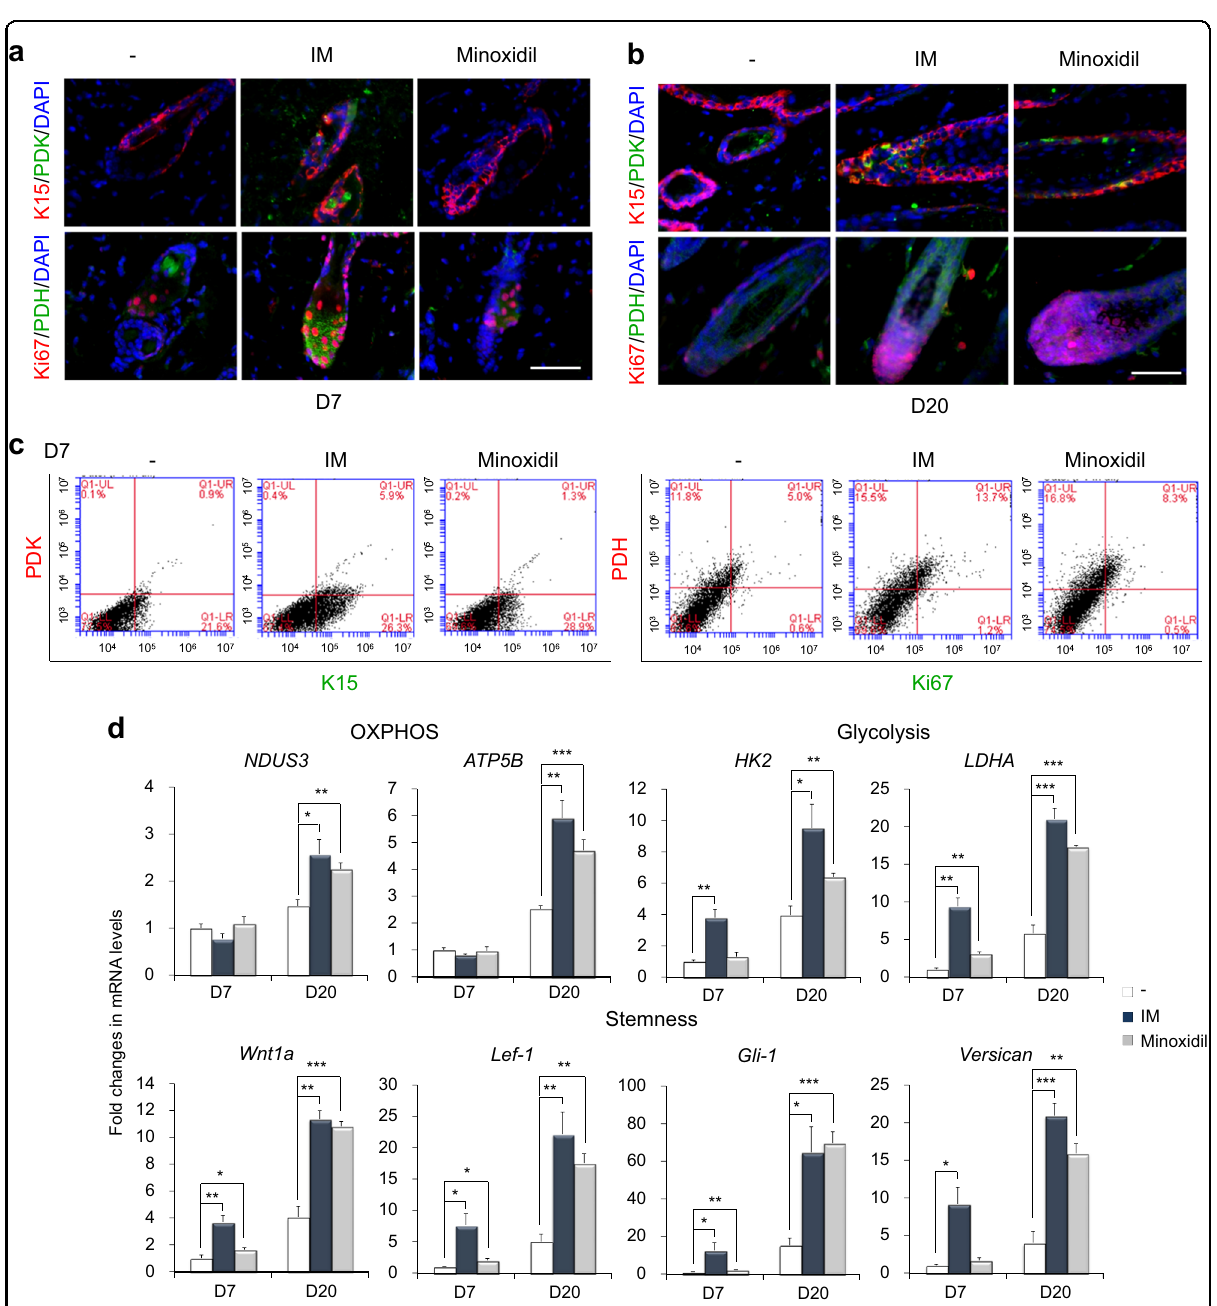
Fig. 6 IM stimulates the expression of stem cell metabolism-related and hair follicle regeneration-related genes during the early phases of hair regrowth. Immunohistochemistry of K15, PDK, Ki67, and PDH in each treated mouse skin on a day 7 and b day 20. DAPI staining was used to identify the nuclei (blue). Scale bar = 50 μ m. c FACS analysis of K15/PDK and Ki67/PDH in single cells of each treated mouse skin on day 7. d Expression of the indicated gene in each treated mouse was quanti fi ed by real-time PCR analysis on days 7 and 20 after depilation. β -Actin expression was used as an internal control. * p < 0.05; ** p < 0.01; *** p < 0.001 (Student ’ s t